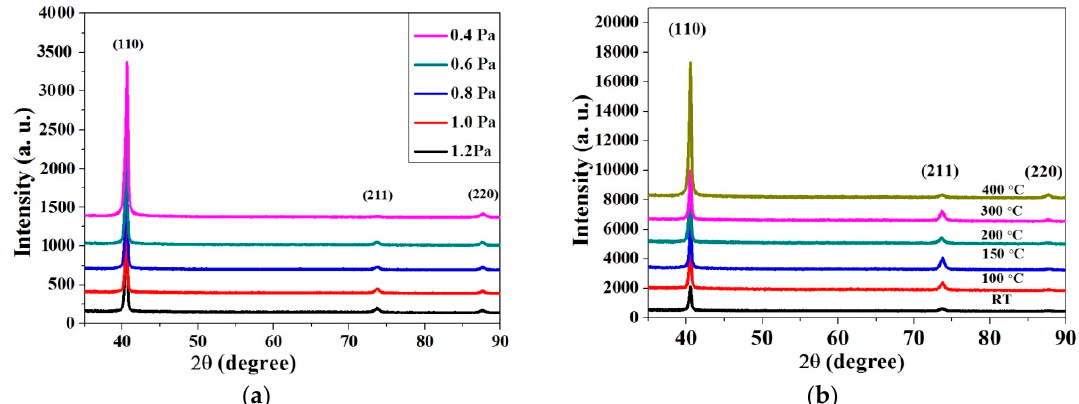
Figure 1. X-ray diffraction (XRD) patterns of Mo bilayer films ( a ) deposited at different bottom layer sputtering pressures and ( b ) annealed at different temperatures.